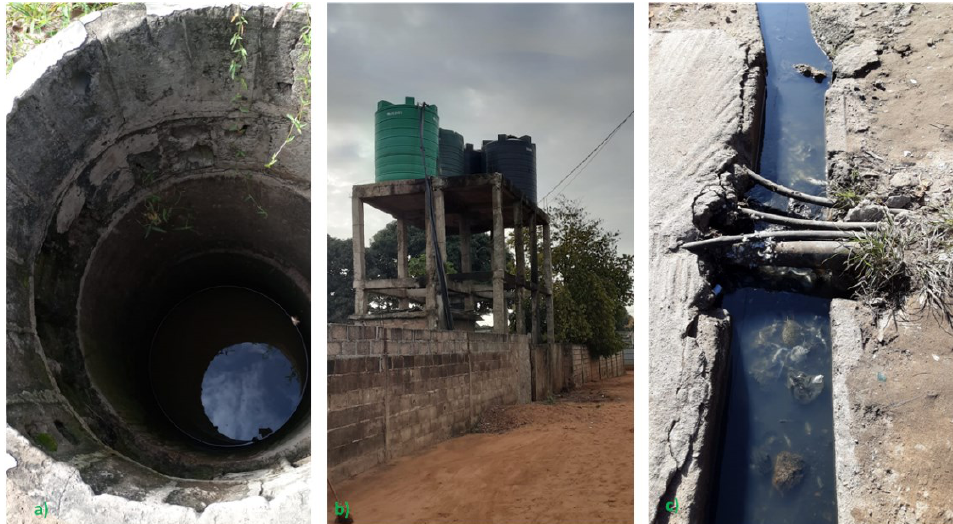
Figure 2. Group II—drinking water sources ( a ) Shallow water well, ( b ) small reticulated water supply systems that relay on groundwater, ( c ) poor water distribution and drinking water distribution system in informal settlements.